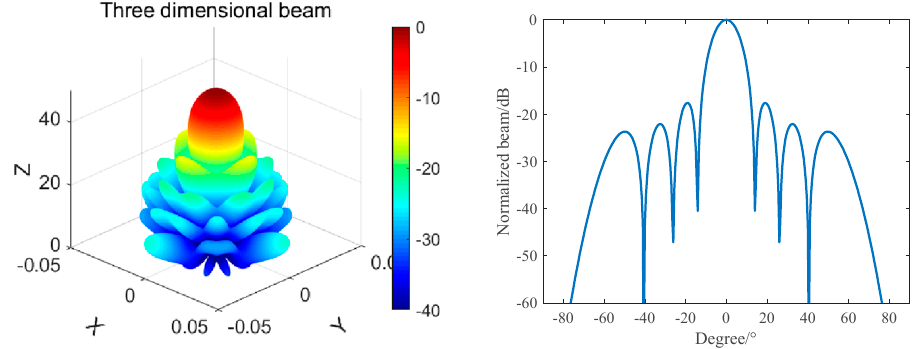
Figure 10. Beam of the 390 kHz Circular Composite Receiving Array.